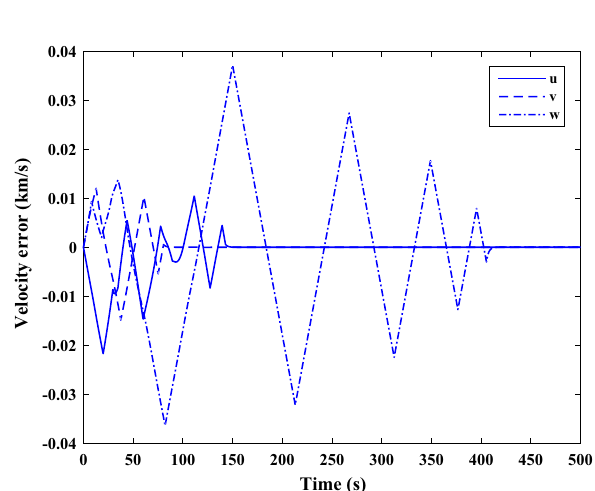
Figure 43. Scenario II: linear velocity tracking (in chaser body frame).